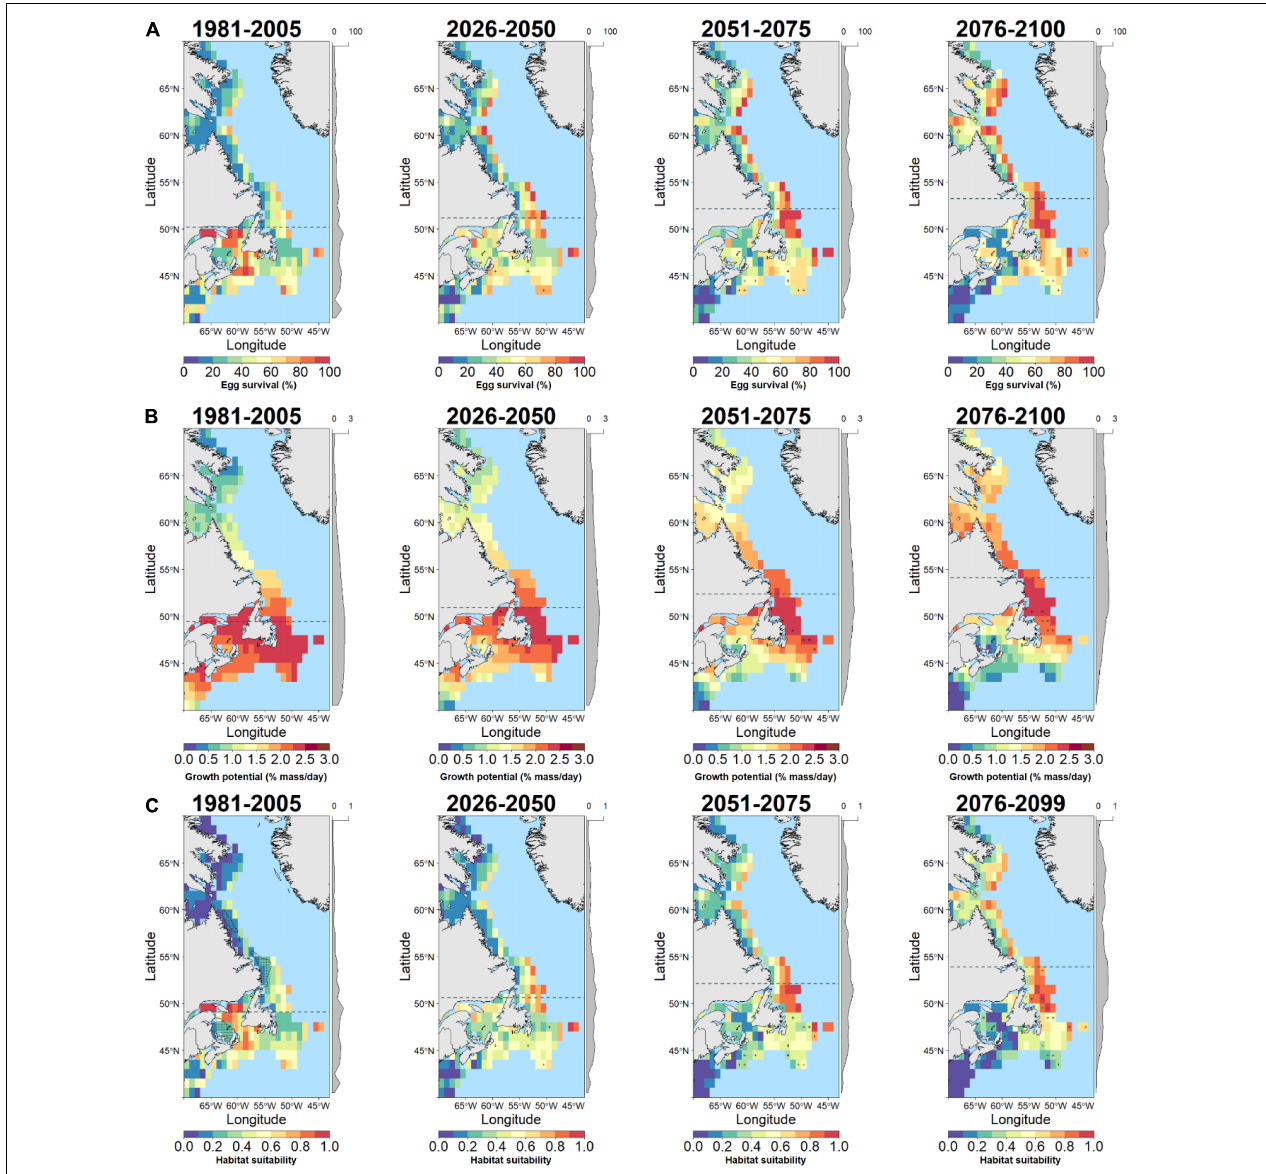
FIGURE 4 | Baseline and future projections of habitat suitability for Greenland cod ( G. macrocephalus ) based on temperature-dependent egg survival (A) , temperature-dependent juvenile growth potential (B) , and geometric means of combined egg and juvenile habitat suitability (C) . Gray cells indicate zero values while cells with high uncertainty (small change relative to spread across models) are indicated by a (+) symbol. The latitudinal component of the distribution centroid is denoted by a dashed gray line across each plot. Marginal plots along the y -axis show the mean cell values across latitude. The current distribution of G. macrocephalus is shown on the baseline habitat suitability (stippled area; bottom left